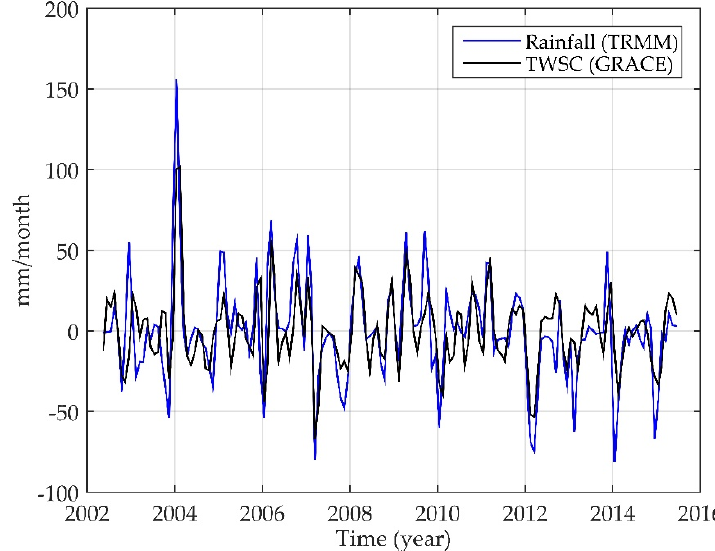
Figure 7. Time series of de-seasoned (with the mean seasonal cycle removed) rainfall (blue solid line) and TWSC (black line) anomalies of SFRB in mm/month.